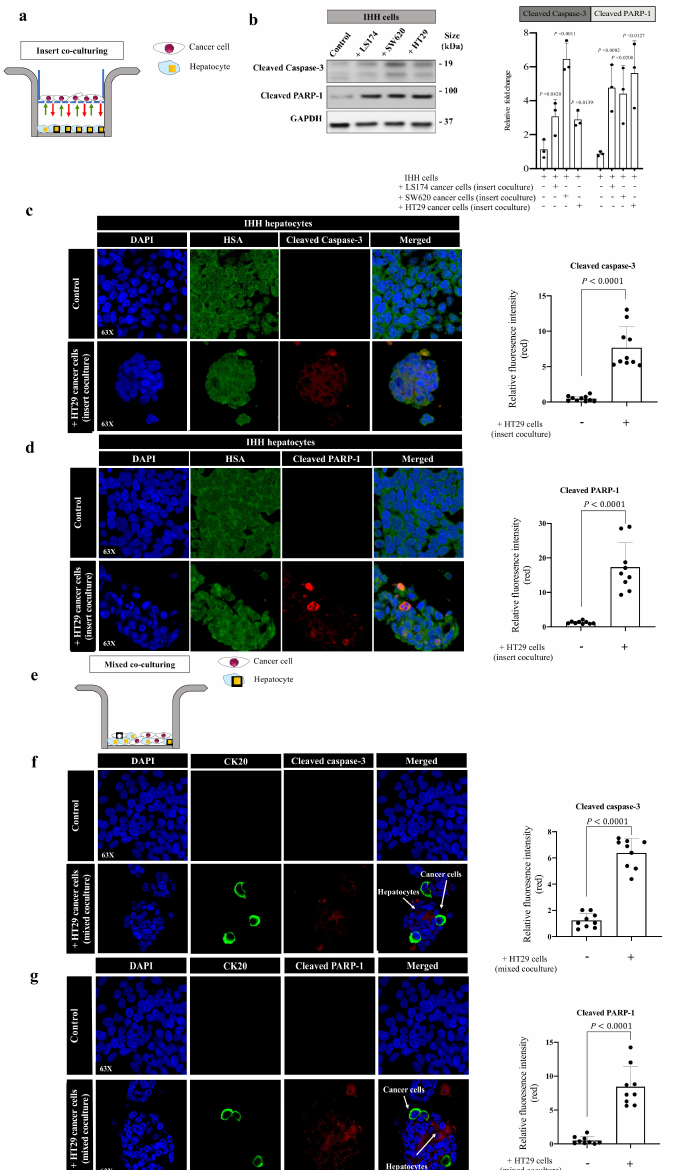
Figure 2. Cancer cells promote apoptosis in hepatocytes in vitro. ( a ) Schematic illustration of indirect (insert) coculturing system. ( b ) The left panel shows immunoblotting of cleaved caspase-3 and cleaved PARP-1 in IHH hepatocytes in the presence or absence of indirect contact with colorectal cancer (LS174, SW620 or HT29) cells. The right panel represents the intensity of cleaved caspase-3 and cleaved PARP-1 bands in three independent experiments. ( c , d ) represent co-immunostaining of IHH hepatocytes indirectly cocultured with HT29 cancer cells using hepatocytes marker, HSA (hepatocyte- specific antigen, green), combined with either cleaved caspase-3 or cleaved PARP-1 (left panel). The right panels represent the quantification of positive pixels. Average pixel intensity was measured from three randomly selected areas for each sample. Results are representative of 3 independent experiments. ( e ) Schematic showing mixed (direct) coculturing system. ( f , g ) Representative images of coimmunostaining for IHH hepatocytes cocultured with HT29 cancer cells using a mixing coculturing system. The cells were stained with cancer cell marker, CK20 (cytokeratin 20, green), combined with either cleaved caspase-3 or cleaved PARP-1 (red). The right panels represent the quantification of positive pixels. Average pixel intensity was measured from three randomly selected areas for each sample. Results are representative of 3 independent experiments. The bar chart shows mean values ±